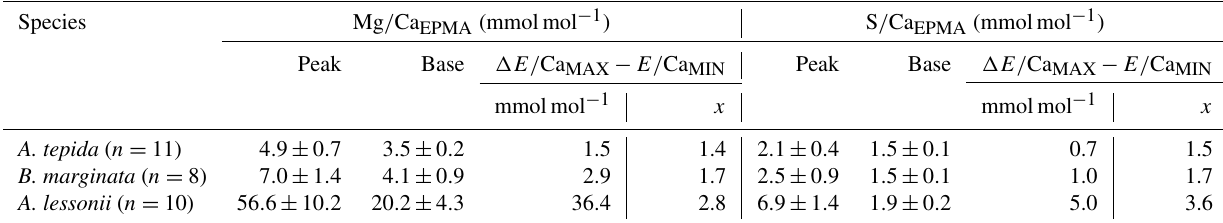
Table 2. Results from peak–base analysis of A. tepida ( n = 11), B. marginata ( n = 8) and A. lessonii ( n = 10), with average peak ( E/ Ca MAX ) and base ( E/ Ca MIN ) values in mmolmol − 1 and (cid:49) MIN − MAX parameters (mmolmol − 1 ; E/ Ca MAX − E/ Ca MIN ) and peak factor ( x ; E/ Ca MAX /E/ Ca MIN ); for details see methodology Sect. 2.3.4).